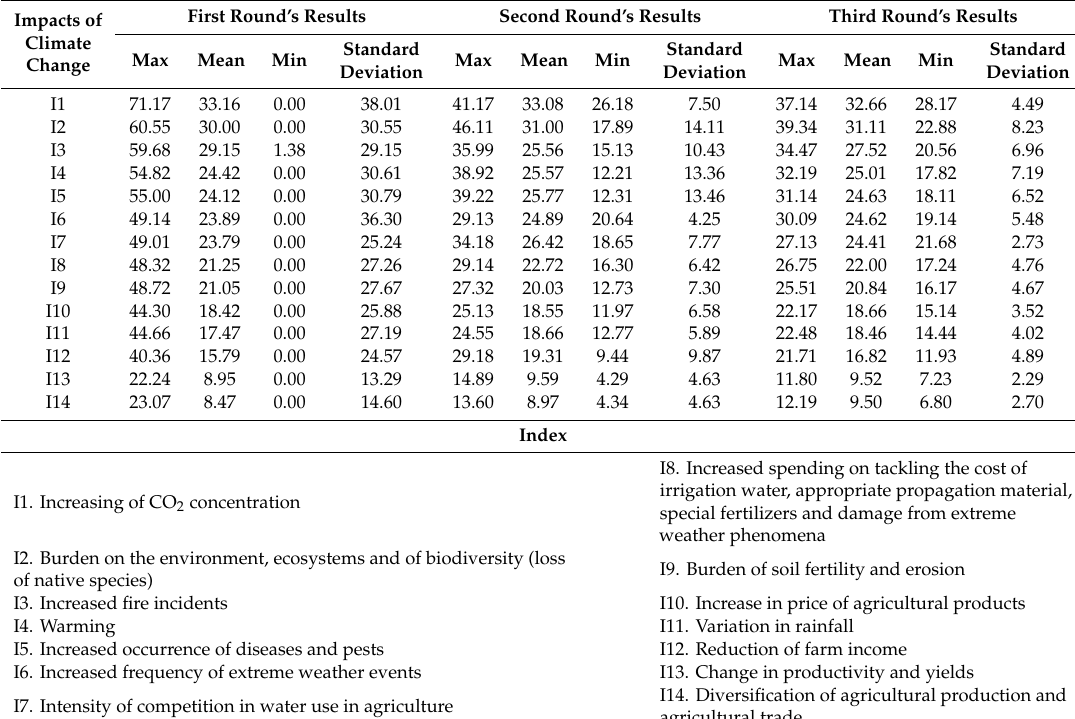
Table 1. Rating results for the Delphi first, second and third round’s Willingness-To-Pay values (EUR maximum, EUR mean and EUR minimum).